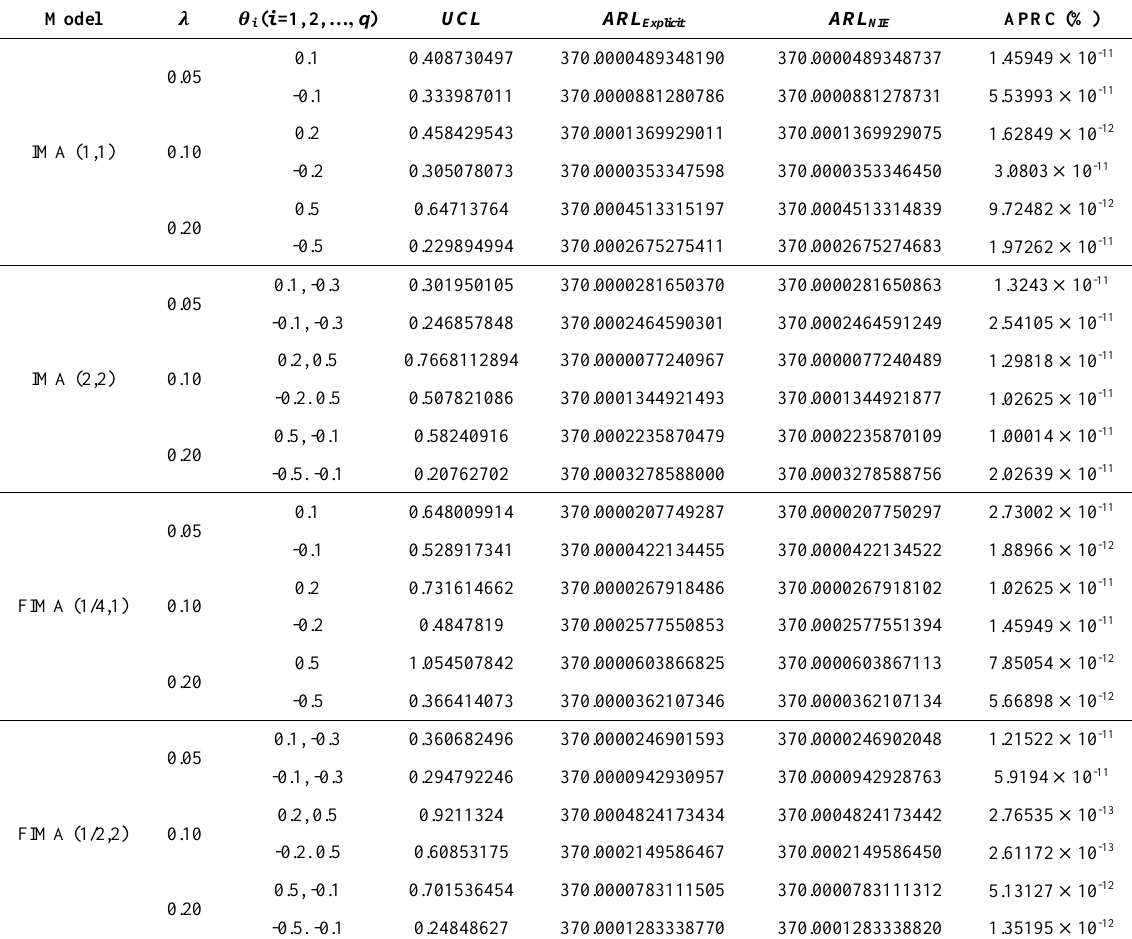
Table 1. Compare the explicit formula and the NIE method with the initial ARL on various situations